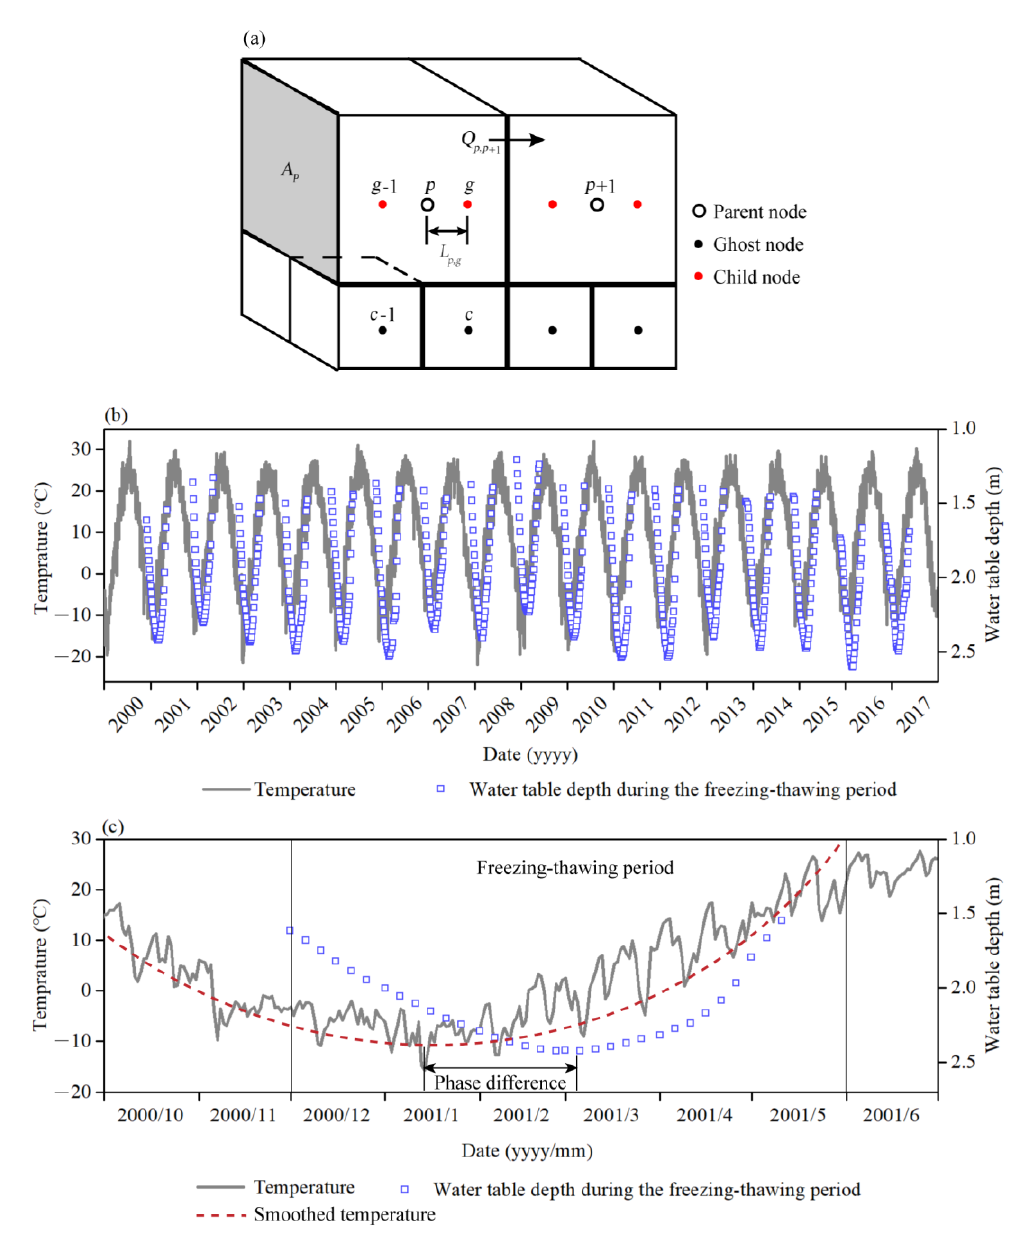
Figure 3. ( a ) The coupling scheme of parent model with the child model in MODFLOW-LGR, ( b ) daily temperature and water table depth in Hetao Irrigation District during the freezing-thawing period, and ( c ) schematic of phase difference between temperature and water table depth in a freezing-thawing period.